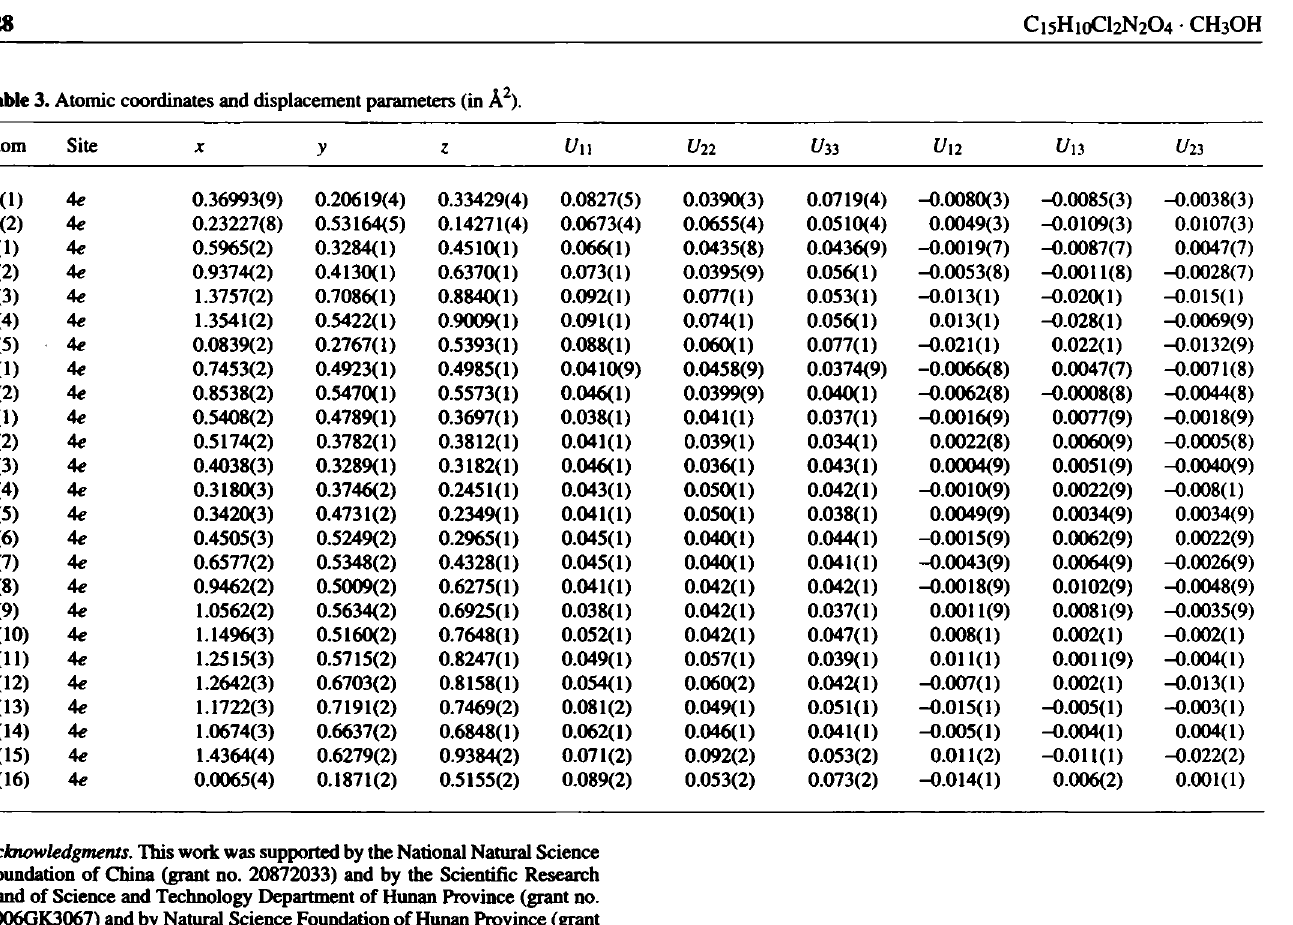
Table 3. Atomic coordinates and displacement parameters (in Â 2